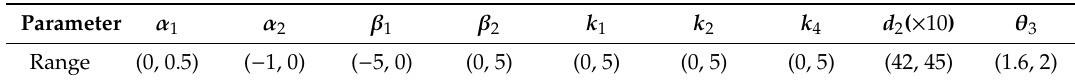
Table 2. Parameters range.